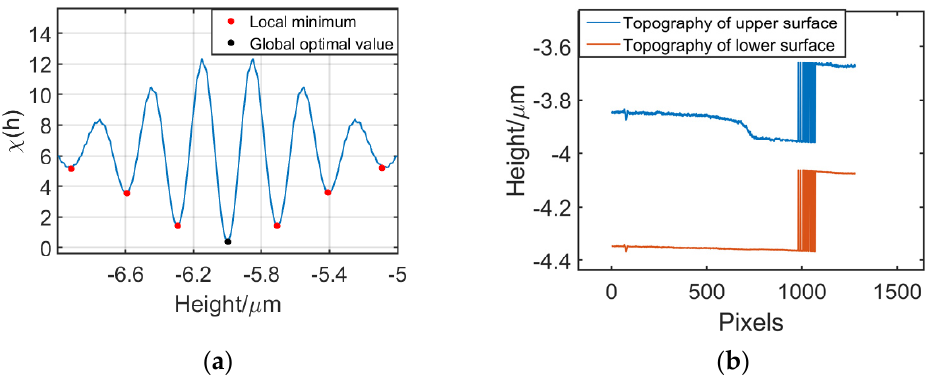
Figure 4. ( a ) Local minima near the global optimal value in the time-domain fitting. ( b ) Incorrect results caused by optimization to local minima. results caused by optimization to local